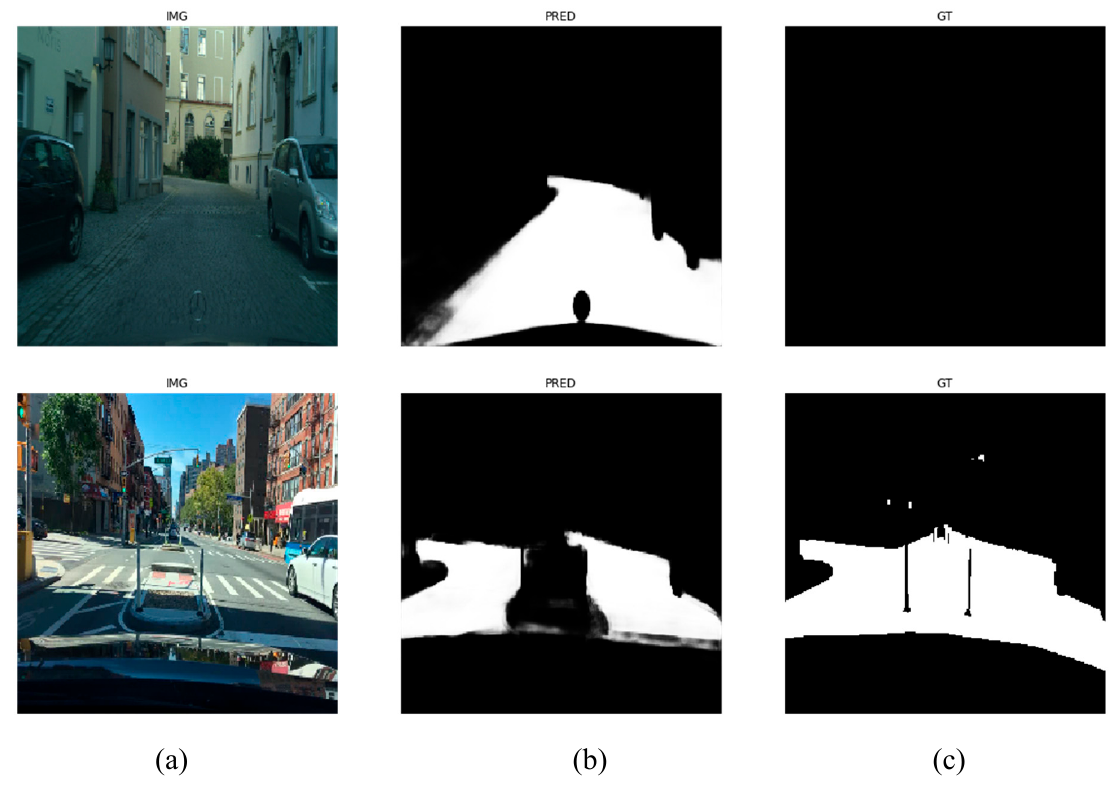
Figure 13. Examples of wrong annotations in the CityScapes [24] and Berkeley Deep Drive [25] datasets. Left column, (a)—input image, center column, (b)—prediction, right column, (c)—ground truth images containing errors.